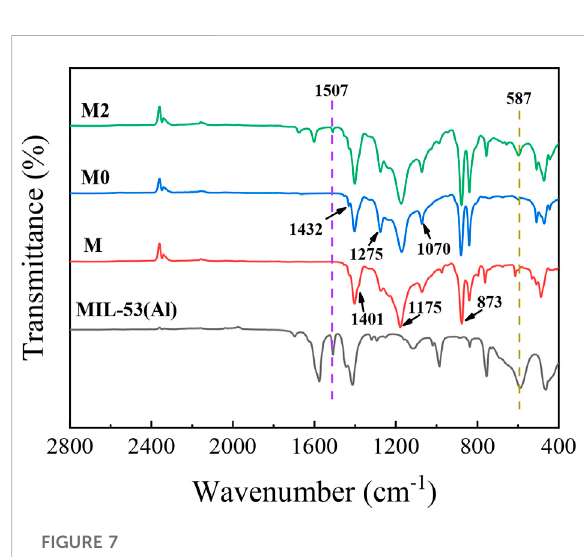
FIGURE 6 Contact angle results of membranes.